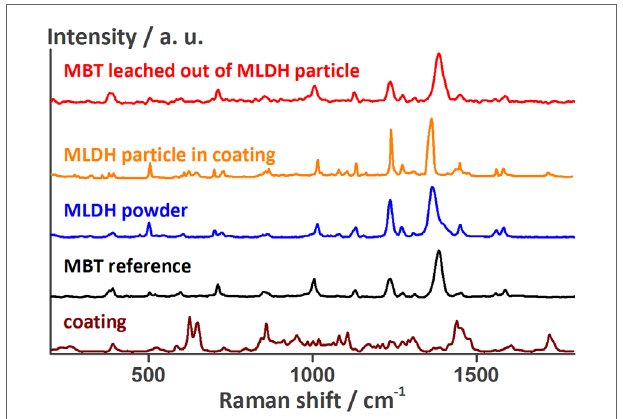
FigUre 2 | raman spectra of a MlDh particle in the Mash coating, of the non-embedded MlDh powder, of MBT, and of the self-healing coating next to the MlDh particle confirming the presence of MBT encapsulated in the Mash coating . The peak assignment can be found in the Table S1 in the Supplementary